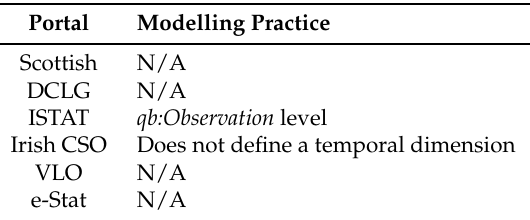
Table 32. Modelling practices of data portals for defining dimensions with a single value in the structure of the data cube.